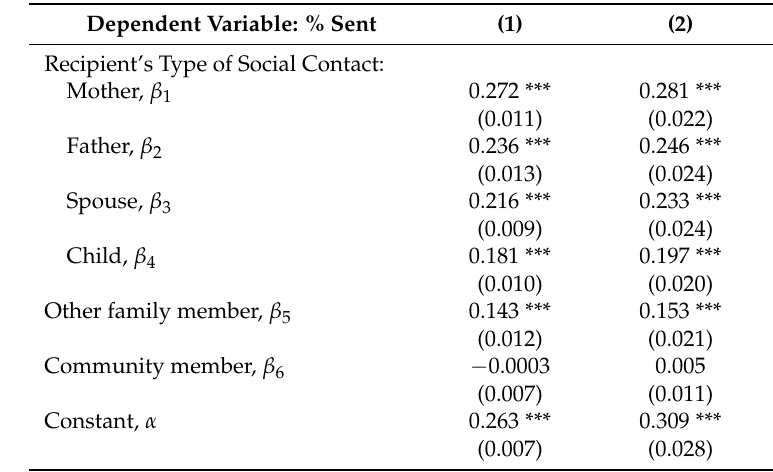
Table 2. Percentage of the endowment sent to the